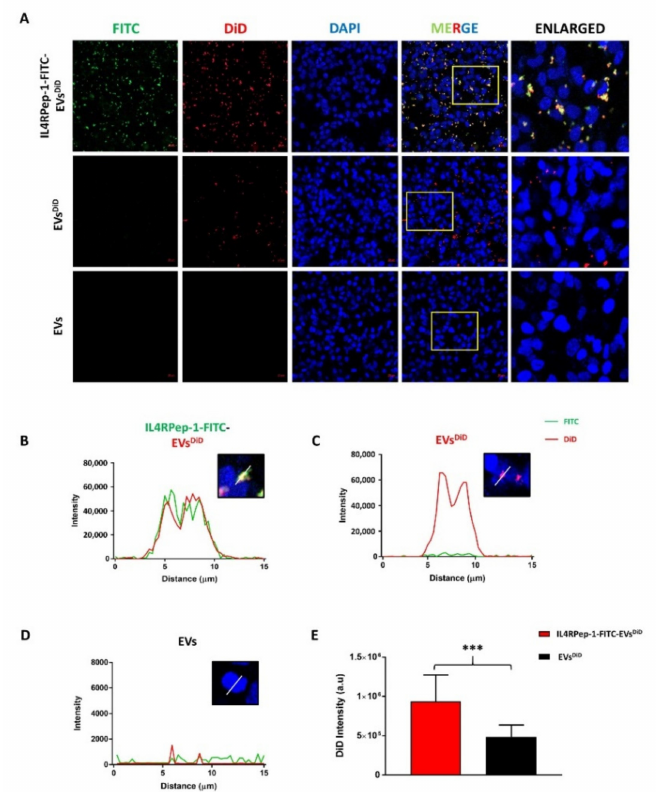
Figure 5. Internalization of IL4RPep-1-EVs by Cal-62 cells. Enhanced internalization of extracellular vesicles (EVs) by IL4RPep-1. ( A ) Immunofluorescent imaging of Cal-62 cells, 1 h post-incubation with 20 µ g of IL4RPep-1-FITC-EV DiD , EV DiD , and EVs; IL4RPep-1 (green) and EVs (red) (scale bar: 20 µ m). ( B – D ) Fluorescent intensity analysis of IL4RPep-1-FITC-EV DiD , EV DiD , and EVs for FITC and DiD by Zen 2.3 software (Zeiss, Baden-Württemberg, Germany) from ( A ) and represented on the graph in arbitrary units. ( E ) Fluorescent intensity analysis of IL4RPep-1-FITC-EV DiD and EV DiD for DiD signals from ( A ) by ImageJ 1.52a software (Wayne Rasband, Maryland, USA), represented on a bar graph. Data are represented as means ± standard deviations (SD). Statistical difference between groups was analyzed using Student’s t -test. *** p <